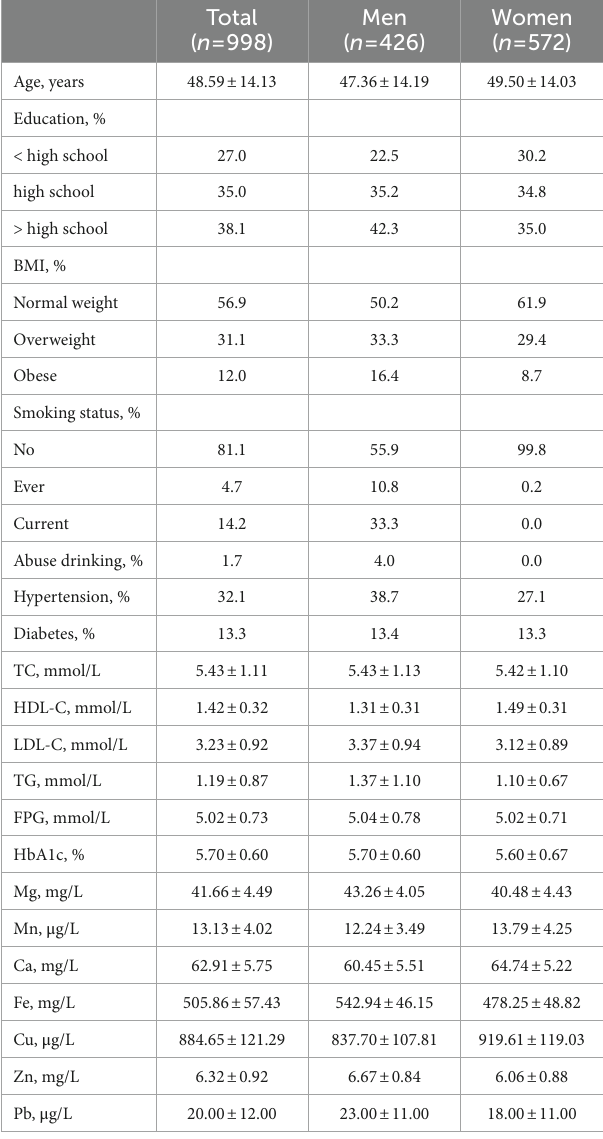
TABLE 1 General Characteristics of participants in the study. TABLE 2 Associations of the mixture of blood Pb and the essential metals with serum lipids